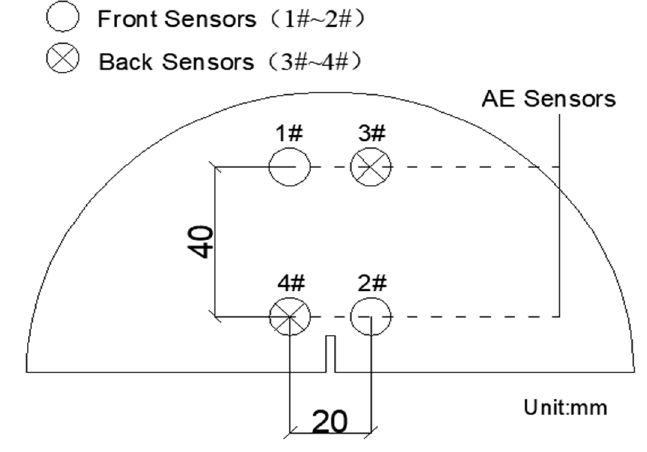
Figure 6. Layout of sensors.